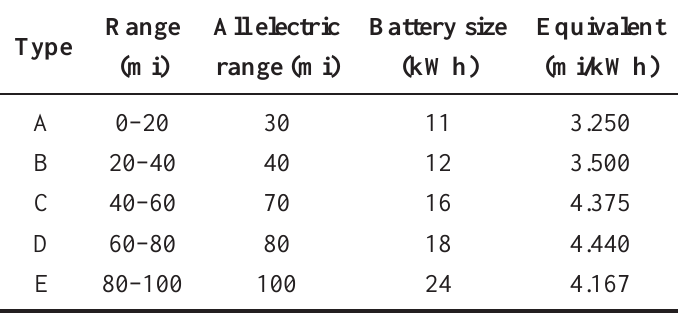
Table 1. Commercially available battery